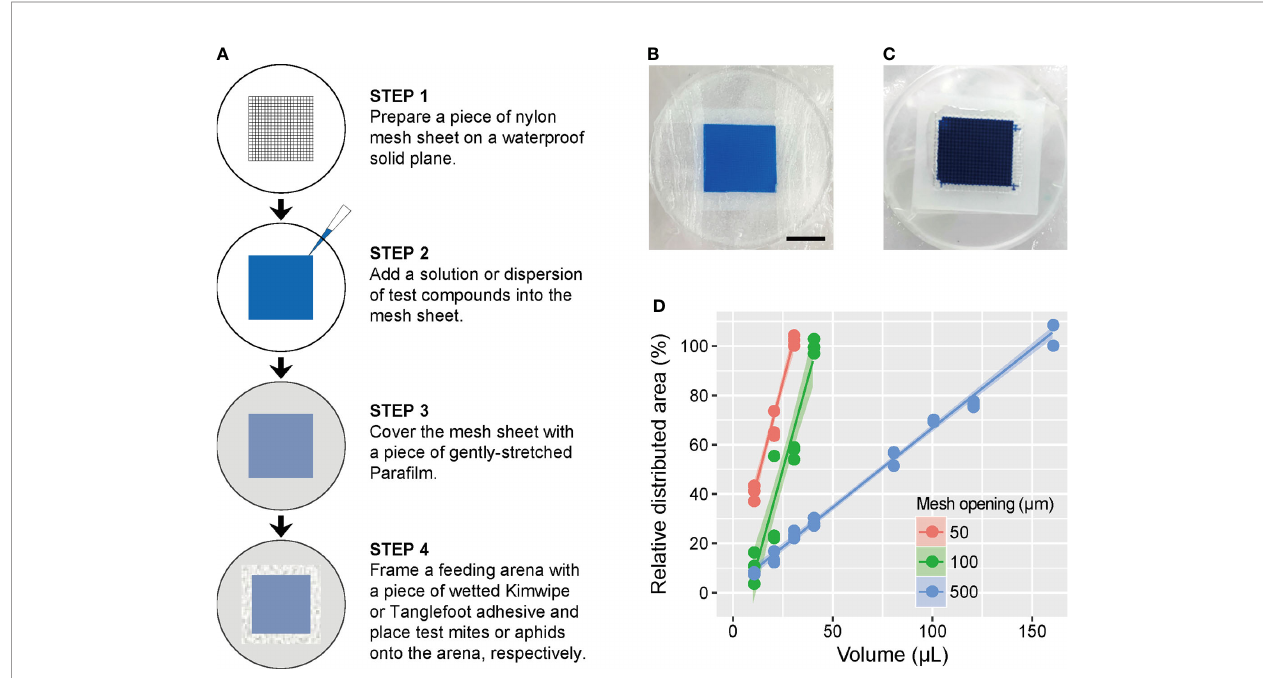
FIGURE 1 | Description of the feeding device in the mesh method. (A) Schematic of the procedure for preparation of the feeding device in the mesh method. Prepared feeding device for (B) mites and (C) aphids, in which a 1 or 2.5% (w/v) blue tracer dye (Brilliant Blue FCF) was added into the nylon mesh sheet (2 × 2 cm) with a 100- or 500-µm opening size, respectively. Scale bar: 1 cm. (D) The relationship between the volume of tracer dye solution and the solution- fi lled area of the nylon mesh sheet (2 × 2 cm) with a 50-, 100-, or 500-µm opening size. Data were collected from three independent experimental runs and are presented with a regression line and a 95% con fi dence interval